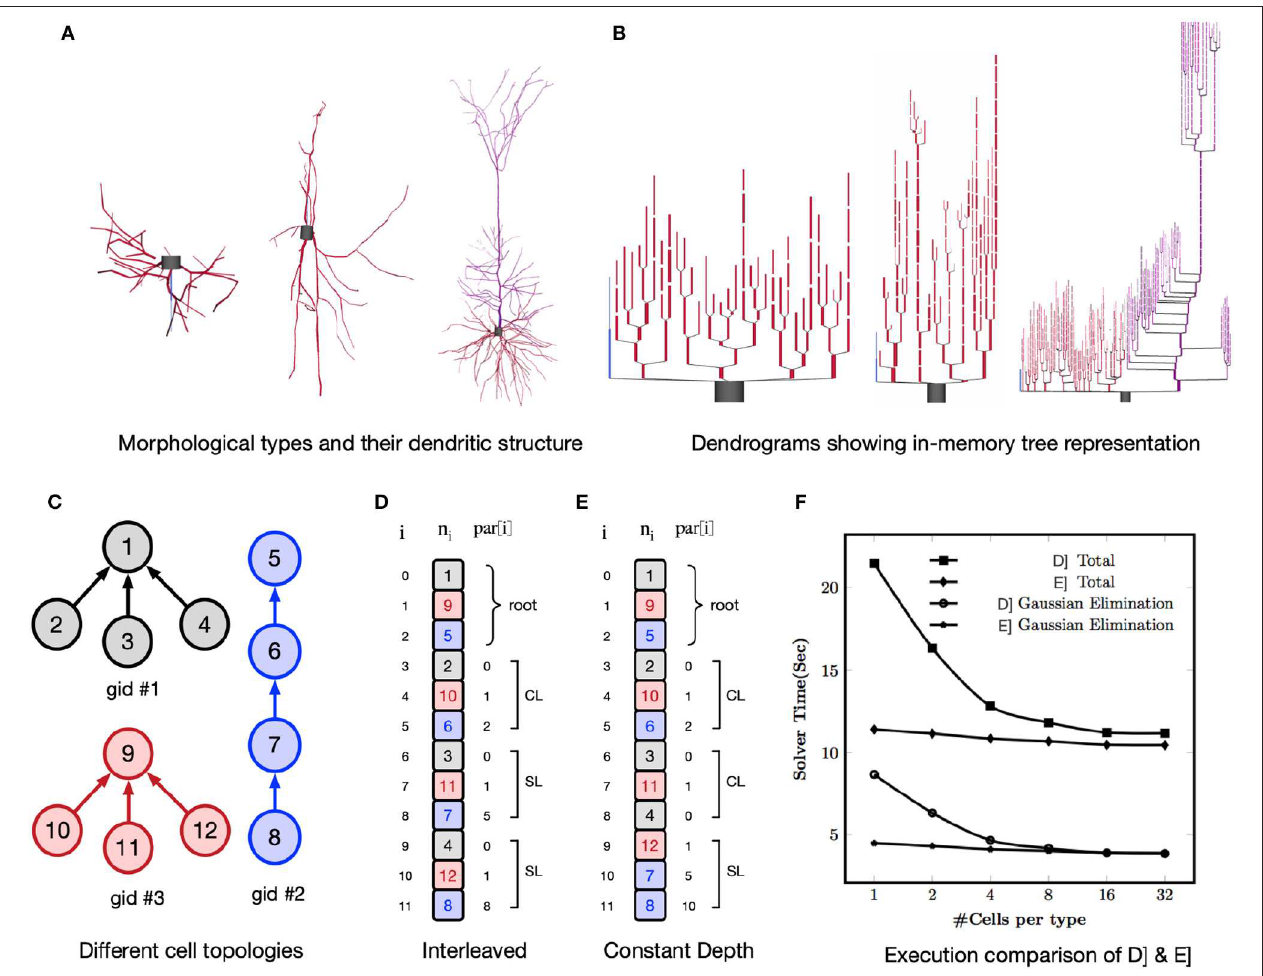
FIGURE 6 | The top row shows three different morphological types with their dendritic tree structure in (A) and dendrograms showing in-memory tree representation of these types in CoreNEURON in (B) . The bottom row shows different node ordering schemes to improve the memory access locality on GPUs : (C) Example topologies of three cells with the same number of compartments; (D) Interleaved Layout where a compartment from each of N cells forms an adjacent group of N compartments. For i th node, n i is node index and par[i] is its parent index. With three executor threads, square brace highlight parent indices that result into contiguous memory load (CL) and strided memory load (SL); (E) Constant Depth Layout where all nodes at same depth from root are adjacent; (F) Comparison of two node ordering schemes for Ring network model showing execution time of whole simulation and Gaussian Elimination